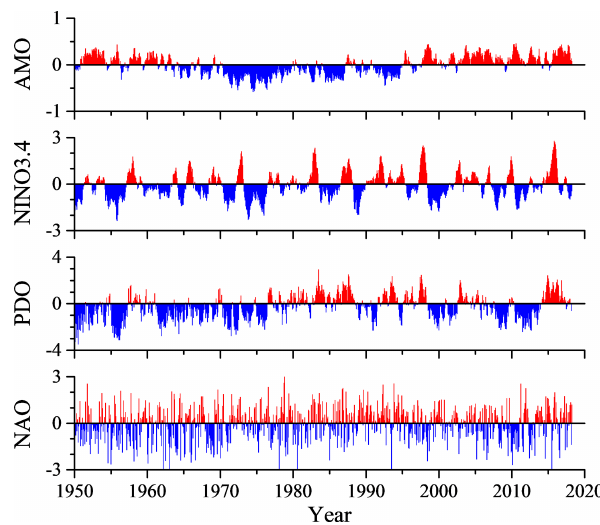
Figure 2. Atlantic Multidecadal Oscillation (AMO) index (a) , NINO3.4 index (b) , PDO index (c) and NAO index (d) during